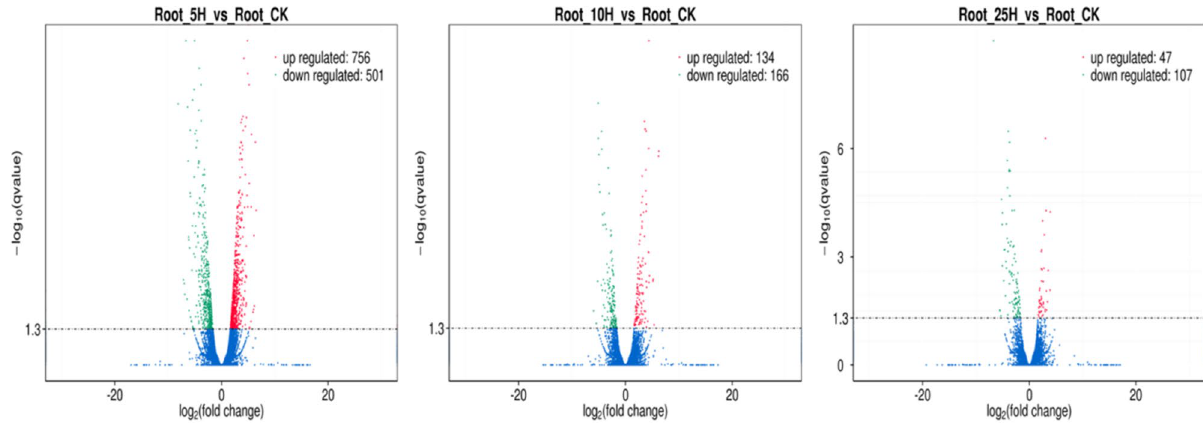
Figure 3. The volcano figures for the DE transcripts in the three comparisons. ‘Up regulated’ represents that the expression of the transcript in Foc TR4 treated sample is higher than the control, ‘down regulated’ represents that the expression of the transcript in Foc TR4 treated sample is lower than the control. The criteria used for screening the DE transcript is: corrected p values < 0.05 and log 2 (fold change) > 1 or < −